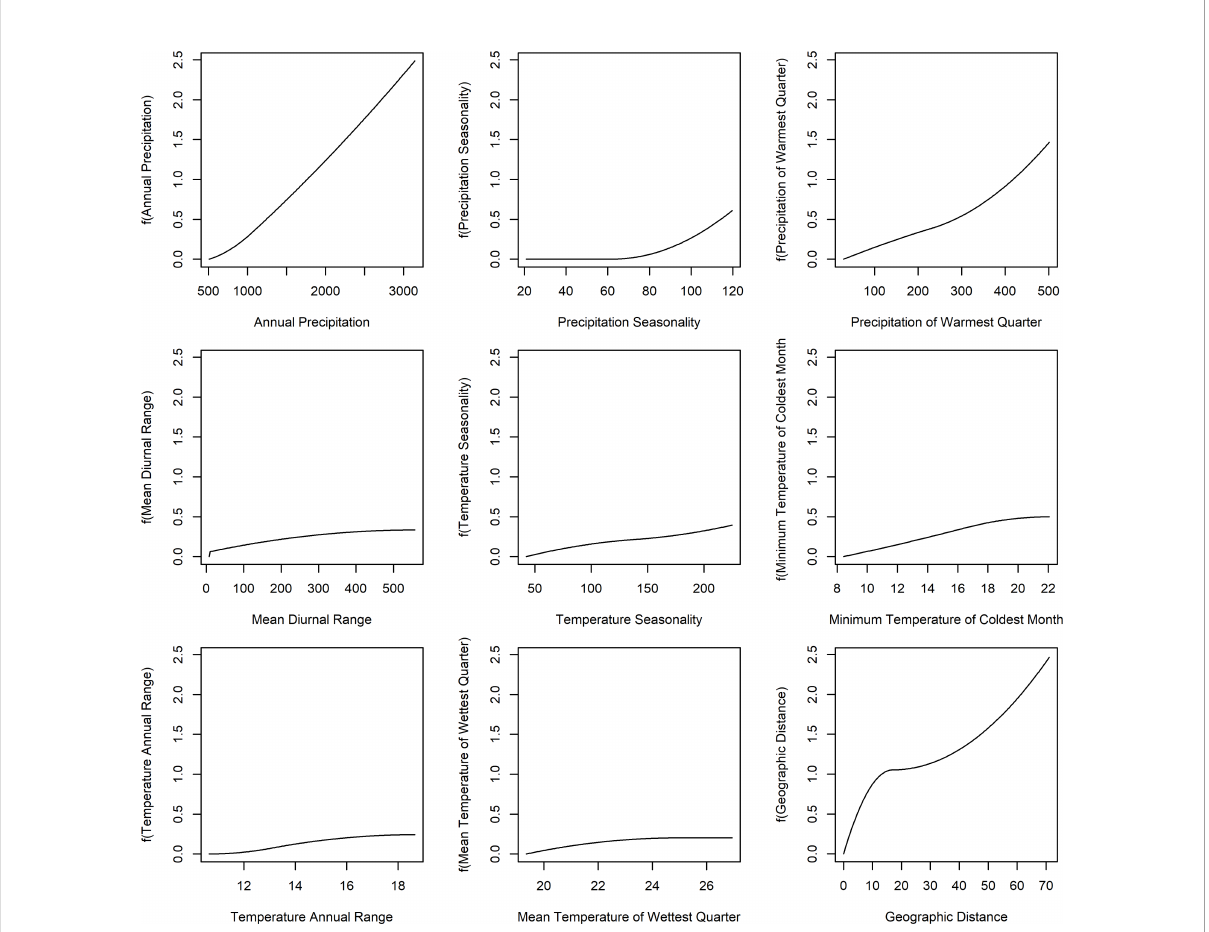
FIGURE 6 Fitted I splines from the generalized dissimilarity models for the nine environmental predictors associated with species turnover in inselbergs. The horizontal axes correspond to the variation in a given predictor, and vertical axes represent the species turnover suggested by dissimilarity